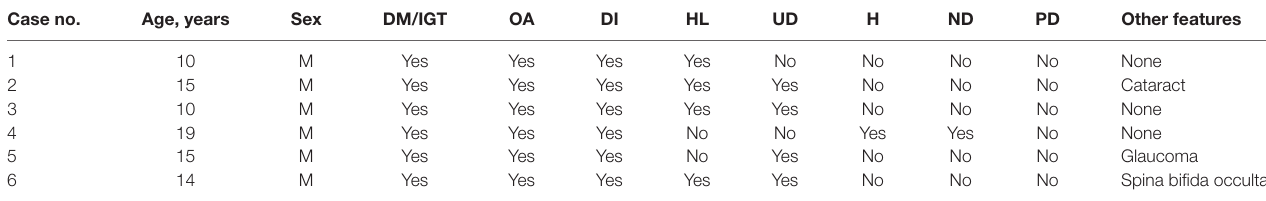
Table 1 | Demographic and clinical characteristics in patients with WS. case no.